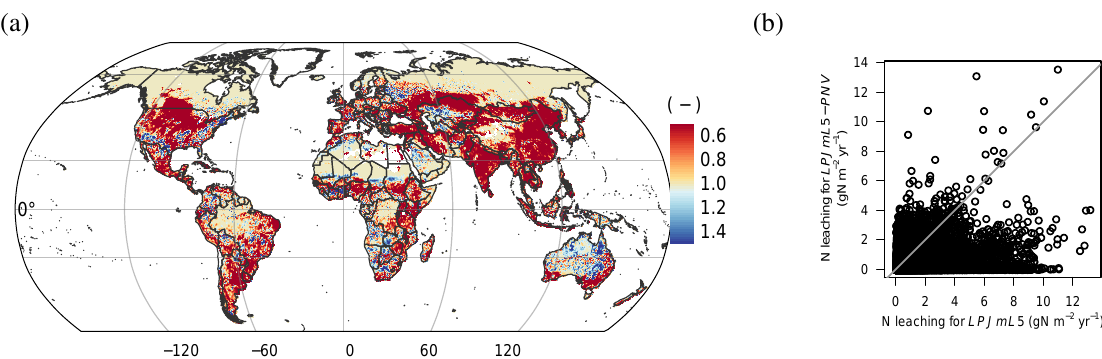
Figure 8. Ratio of leaching flux under potential natural vegetation ( LPJmL5-PNV ) to the leaching flux under actual land use patterns ( LPJmL5 ) (a) ; values less than 1 indicate higher leaching under actual land use patterns. The scatter plot in (b) shows that leaching is increased strongly mostly in regions where leaching is low under potential natural vegetation.